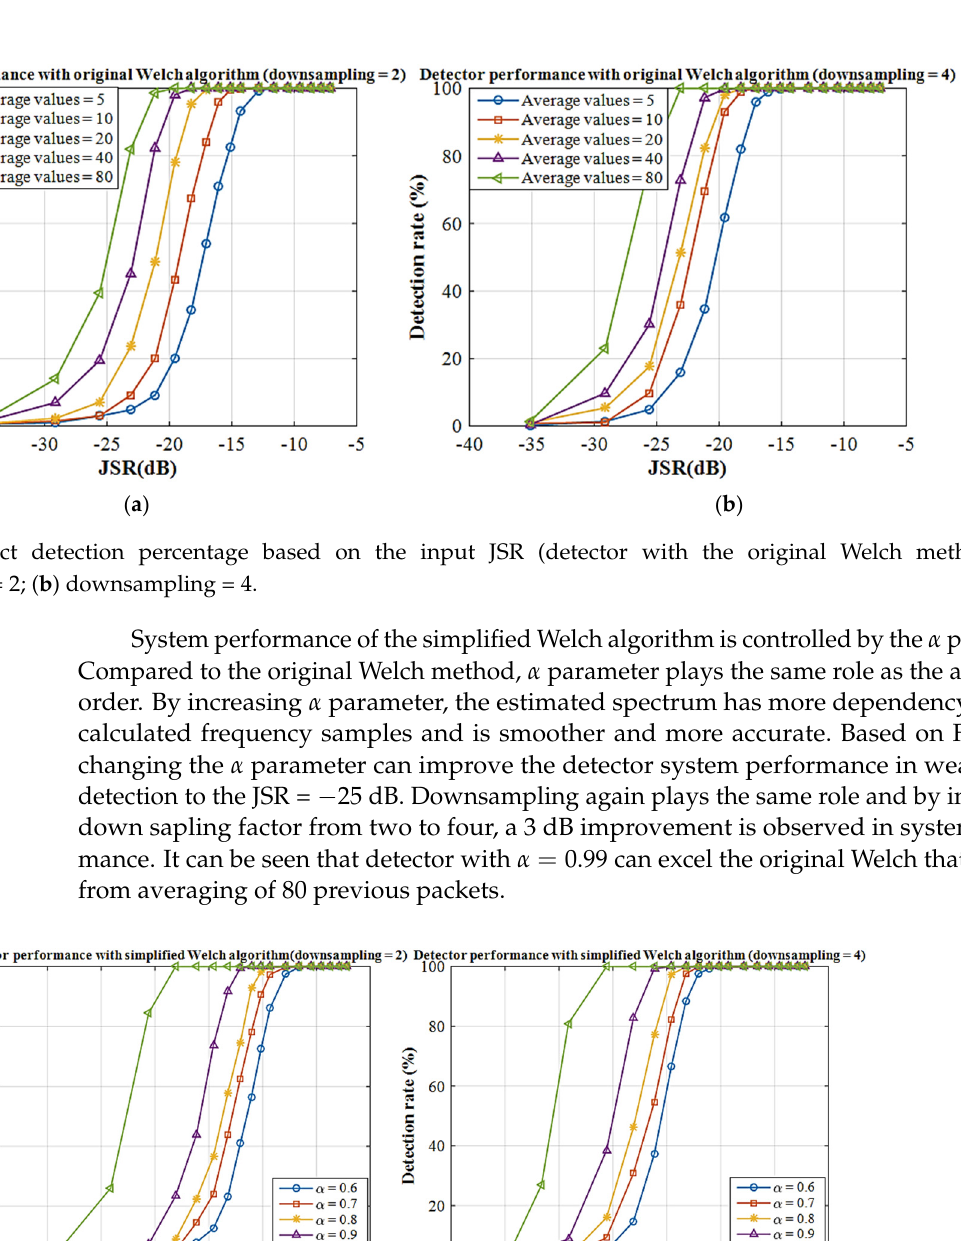
Figure 14. Least Mean Square (LMS) detector [19] performance based on the input JSR ( (cid:2013) (cid:3021) = 10 (cid:2879)(cid:2871) ). Based on the previous results, utilizing more packets from the past increases the sys- tem capability in weak interference detection; however, the cost of this improvement is more convergence time and slower reaction to interferences with the variable center fre- quencies. Consider that the target of the system is to track the interference with hopping center frequency. Depending on the variation speed of center frequency, large depend- ency on the past can decrease the system performance. Let us consider that the sample rate of the system is large enough and during one FFT window, the interference has a constant center frequency. Now, the period of the variation of interference center fre- quency is an integer multiply of window duration. For simplicity, we normalize a window duration to one second. Figure 15 displays the detector performance in hopping CWI tracking based on the variation speed of the center frequency. In this test, the power of